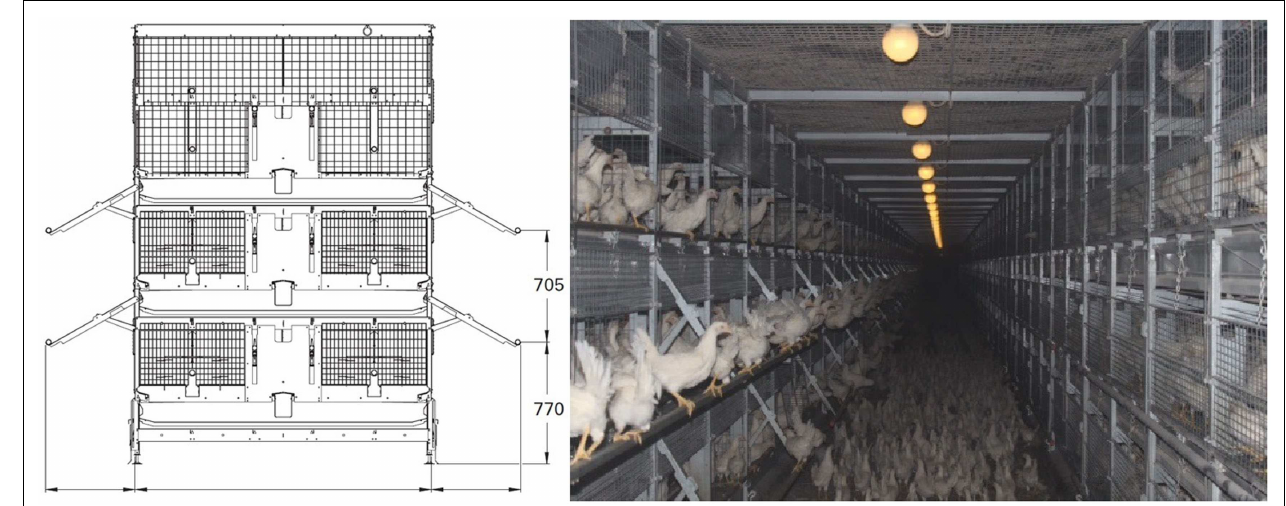
of the photograph and the floor represent the conditions for aviary-reared birds.The right side of the photograph indicates the conditions for cage-reared birds, apart from the fact that birds were not housed in the third tier. In the present study, cage- and aviary-reared birds faced separate corridors.The width of corridors was